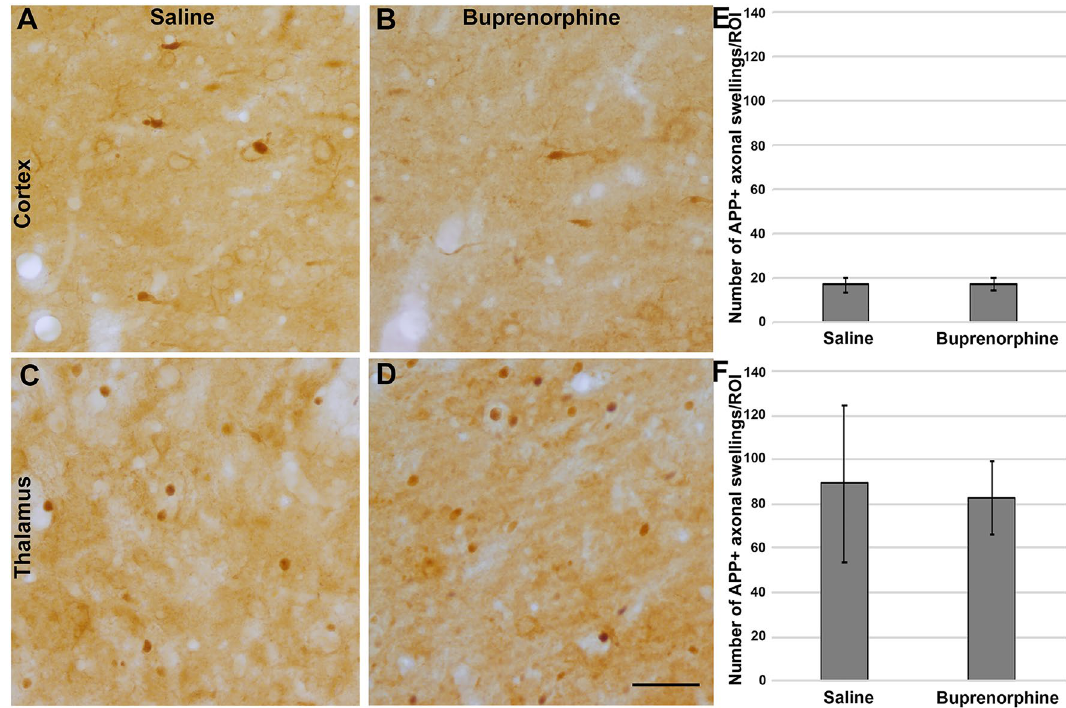
Figure 3. Buprenorphine did not alter acute diffuse axonal injury in either the thalamus or cortex. Representative photomicrographs of ( A , C ) saline or ( B , D ) buprenorphine treated Sprague Dawley rats 1d following cFPI. Tissue samples of ( A , B ) somatosensory neocortex and ( C , D ) hemithalamus were labeled immunohistochemically with a primary antibody against amyloid precursor protein (APP) and a secondary biotinylated antibody followed by DAB reaction. Swellings were visualized and quantified to assess axonal injury in each brain region at 1d following cFPI and either saline or buprenorphine treatment. ( E , F ) Corresponding bar graphs depicting the number of swellings per region of interest in the ( E ) cortex and ( F ) thalamus. The number of swellings was consistent between saline and buprenorphine treated animals, indicating that buprenorphine does not affect axonal injury in observed regions following TBI. Figure was compiled using Adobe Photoshop CS., version 22.0 (2020), San Diego, CA. n = 6 rats/group; Mean ± SEM. scale = 50 p = 0.01; Fig. 6G). There were also significant regional differences in the morphology of astrocytes in the control animals, with more astrocytes (Two-way-ANOVA; Region F = 1,16 = 9.49, p = 0.007) covering a larger proportion of the image (Two-way-ANOVA; Region F = 1,16 = 8.43, p = 0.01) in the thalamus of saline-treated control animals compared to the cortical astrocytes. These regional differences were not maintained following Bup treatment (Fig. 6). The size of astrocytes, however, was (Two-way-ANOVA; Region F = 1,16 = 24.04, p < 0.001; Fig. 6G). The circularity of astrocytes was also consistent between treatment groups and ROIs (One-way-ANOVA; F 3,16 = 0.85, p = 0.49; Fig. 6H). There were no interactions between region and treatment for any metrics. Treatment with Buprenorphine altered myelin basic protein (MBP) isoforms but not overall MBP expression. In order to assess the effect of Bup on myelin pathology at 1d post-CFPI, immunohisto- chemical labeling (Fig. 7A–D) and Western blotting were performed to evaluate myelin integrity and the expres- sion of myelin basic protein (MBP). There was no significant difference in the total number of intact myelin fibers (One-way-ANOVA F 3,12 = 1.224, p = 0.344) or myelin debris (One-way-ANOVA F 3,12 = 0.558, p = 0.653) between ROI or drug treatment groups (Fig. 7E). Furthermore, overall MBP expression did not appear to be significantly altered with Bup treatment in either region (Two-way-ANOVA Treatment F 1,16 = 0.064, p = 0.803). There did appear to be statistically significant regional differences, however, where overall expression of MBP was higher in the cortex than the thalamus, regardless of drug treatment group (One-way ANOVA F 3,16 = 11.22, p < 0.001; Two-way-ANOVA; Region F 1,16 = 33.576, p < 0.001). As the different MBP isoforms are linked to dif- ferent developmental stages of myelination 42 , the individual MBP isoforms (21.5 kDa, 18.5 kDa, 17.2 kDa, and 14.0 kDa) were also analyzed. Similar to analysis of the overall expression of MBP, the expression of individual MBP isoforms was not statistically different between Bup and saline treatment groups (Two-way ANOVA; Treat- ment 21.5 kDa: F 1,16 = 0.054, p = 0.819, 18.5 kDa: F 1,16 = 0.127, p = 0.727, 17.2 kDa: F 1,16 = 0.001, p = 0.982, and 14.0 kDa: F 1,16 = 1.85, p = 0.673; Fig. 7G). There were, however, statistically significant regional differences for all isoforms (One-way ANOVA; 21.5 kDa: F 3,16 = 12.410, p < 0.001, 18.5 kDa: F 3,16 = 6.363, p = 0.005, 17.2 kDa: F 3,16 = 17.202, p < 0.001, and 14.0 kDa: F 3,16 = 5.364, p = 0.01) in which the expressions of all isoforms were higher in the cortex of either saline or Bup treatment group compared to the thalamus (Two-way ANOVA Region